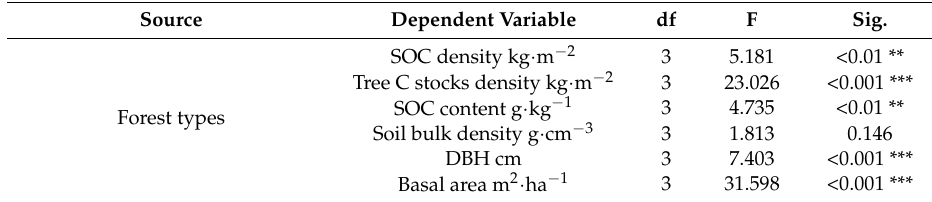
Table A2. Tree and soil carbon stocks differences in different forest types, ring roads, administrative districts, urban area settlement time of urban forests in Harbin City: One-way ANOVA